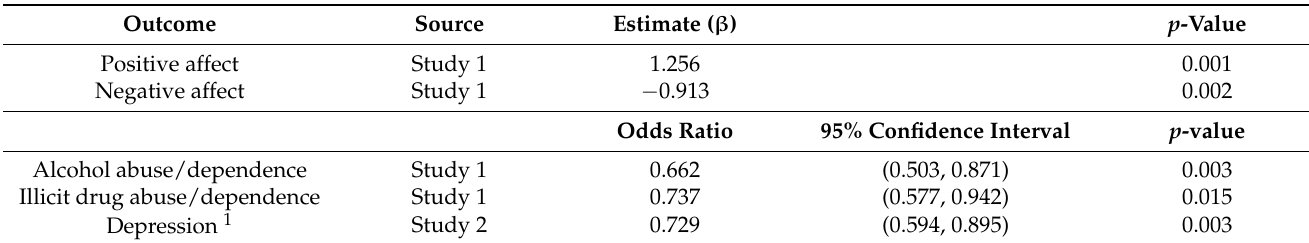
Table 4. Bivariate associations of PGA with select